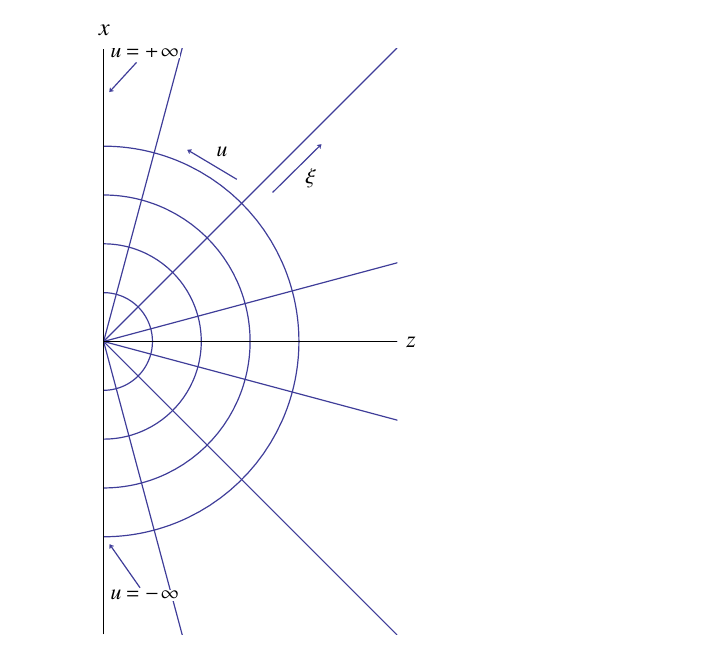
Figure 10. Relation between Poincar(cid:19)e coordinates ( x; z ) and AdS-slicing coordinates ( (cid:24); u ). Con- stant u curves are half straight lines all ending at the origin ( (cid:24) ! 0 (cid:0) ); constant (cid:24) curves are semicircle joining the two halves of the boundary at u = (cid:6)1